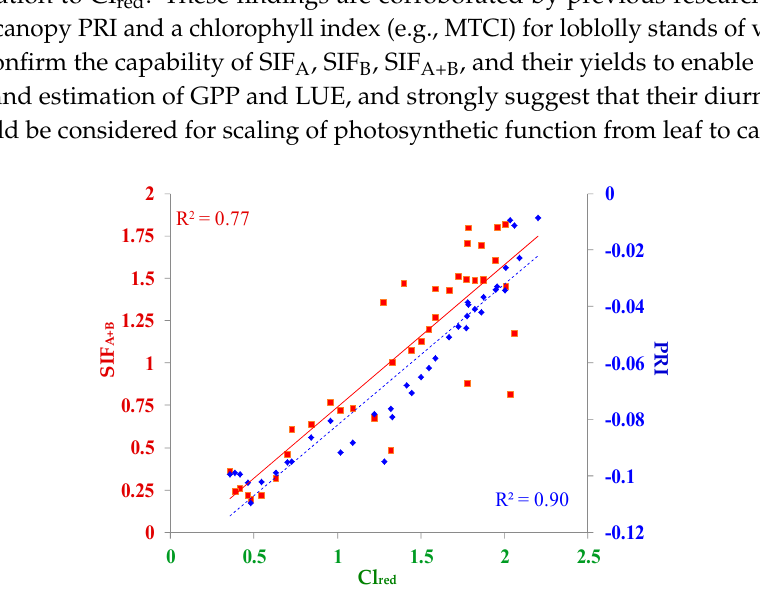
Figure 8. Association of midday SIF A+B (red, left axis, PAR ≥ 1150 µmol/m 2 /s) and PRI (blue, right axis) to canopy chlorophyll, as captured by Cl red . The midday values are calculated from the observations collected within ±1 h of local solar noon, and include 58 days from four growth stages of corn.